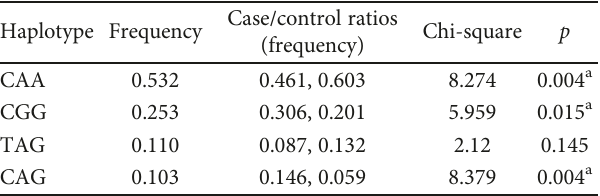
Table 6: Haplotype distribution belongs to CTLA-4 polymorphisms between Pv patients and